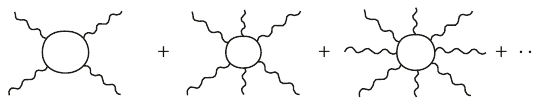
F igure 2 : Cut diagrams giving the imaginary part of the amplitudes.